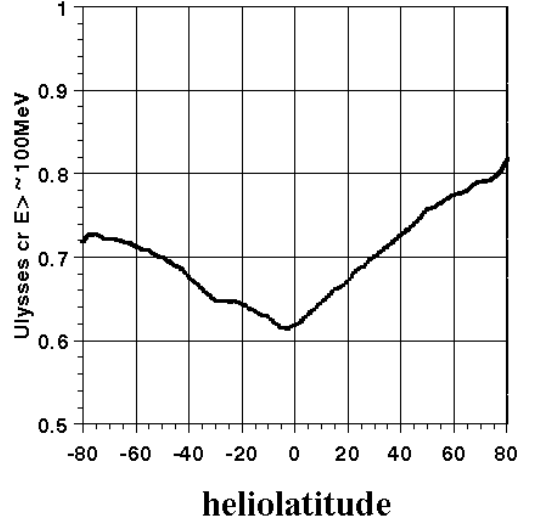
Fig. 2a. The heliolatitudinal variation of the cosmic-ray intensity for different values of the model parameters γ 1 and γ 2 , 3 a) γ 1 = 1 . 75 e − 5 and δ = 10 b) γ 1 = 2 . 5 e − 5 and δ = 7 c) γ 1 = 1 . 0 e − 5 and δ = 10 d) γ 1 = 1 . 25 e − 4 and δ = 10 and e) γ 1 = 1 . 25 e − 5 and